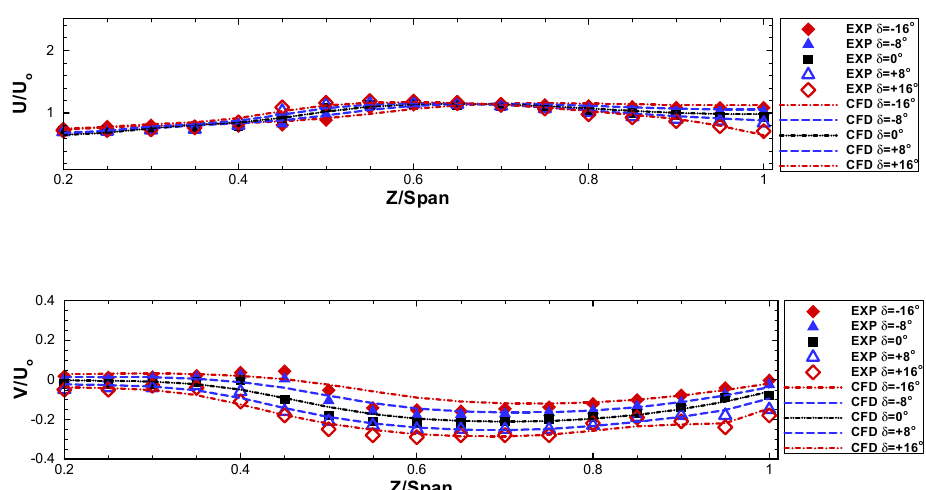
Figure 17. Velocity profiles of flat-type rudder inflow obtained from the experiment and numerical calculations.